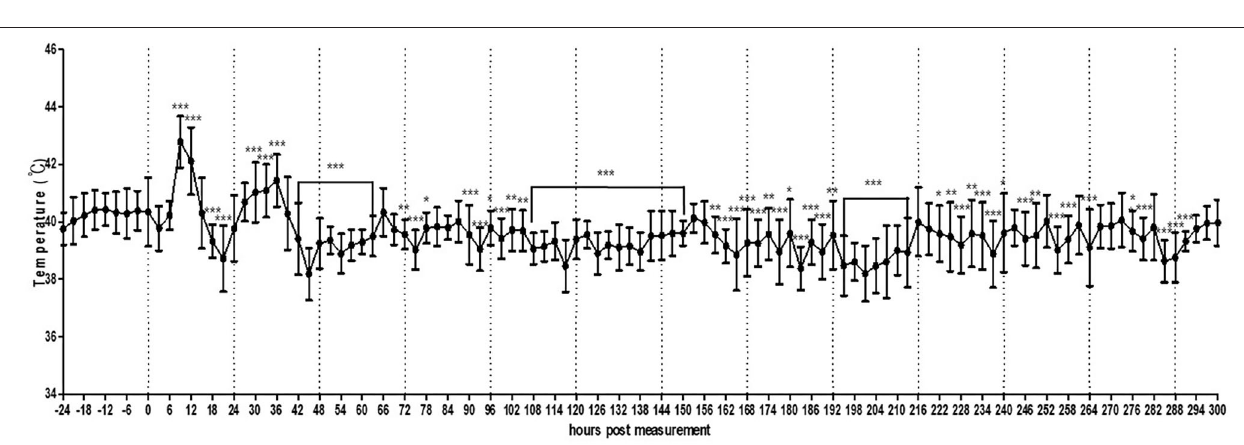
FIGURE 4 | Average temperature per 3h interval before and after HPAI virus challenge in a duck intranasally challenged with virus at 10 4.0 EID 50 /bird dose. The error bars represent standard deviations of 36 5-min time points. Statistical significance was determined by ANOVA, followed by Bonferroni post-hoc test. *** P < 0.001; ** P < 0.01; * P <